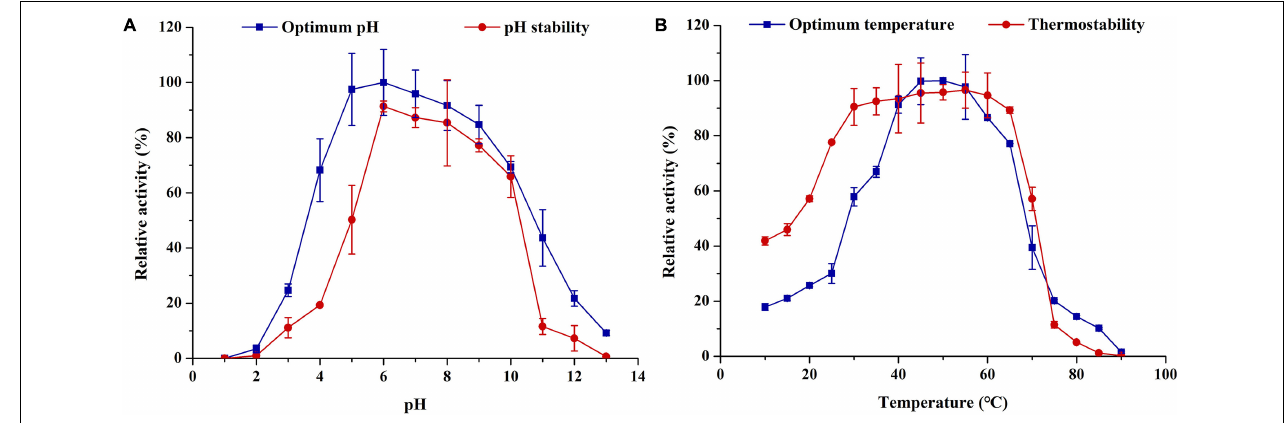
FIGURE 3 | (A) Optimum pH and (B) thermostability of laccase ThLacc-S from Trametes hirsuta .